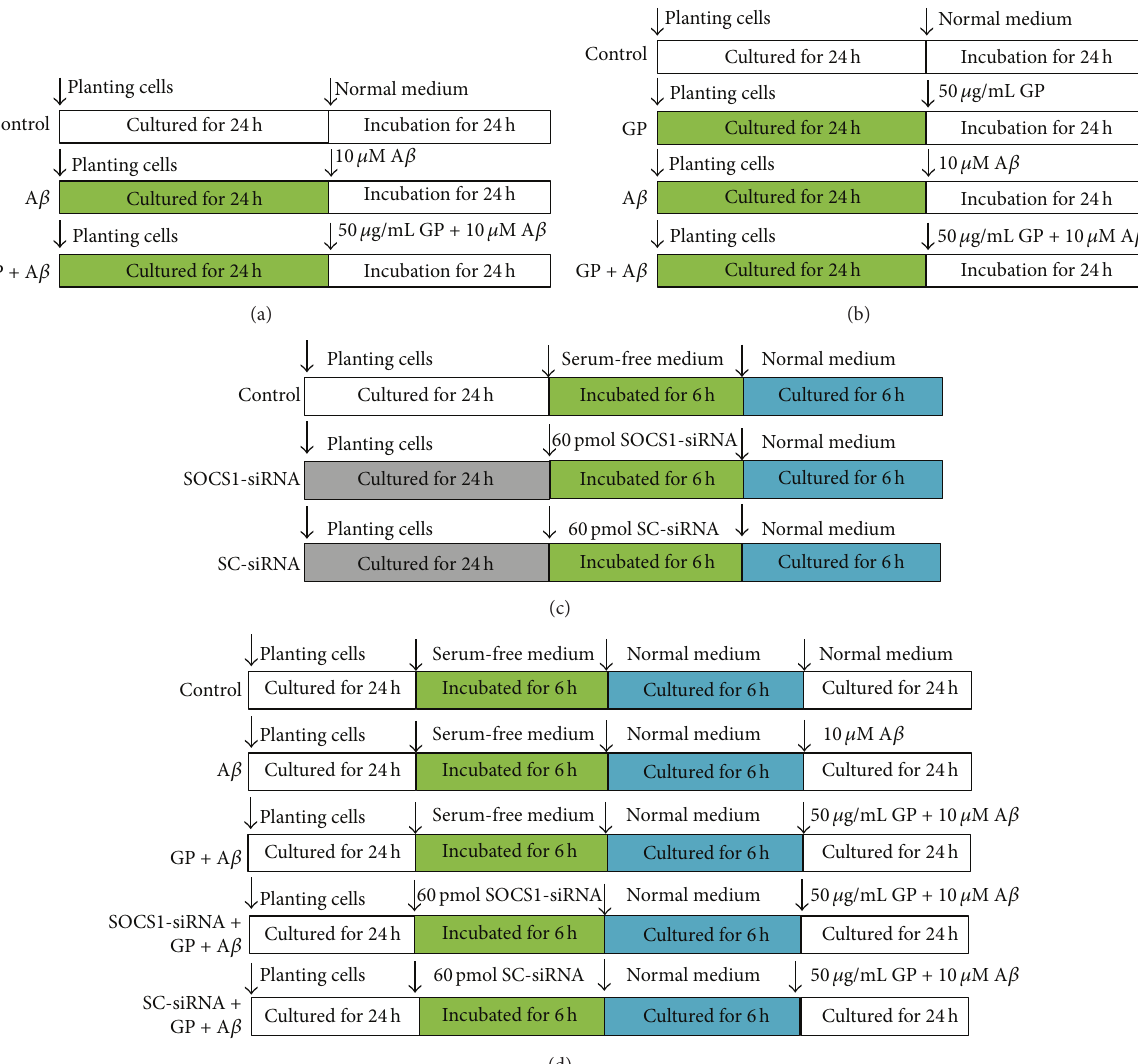
Figure 1: Experimental protocol diagram. (a) The N9 cells were divided into three groups; after being treated for 24h as shown in the figure, western blot analysis and immunocytochemistry were performed to assess iNOS and Arg-1 protein expressions. (b) The cells were divided into four groups, after 24-h incubation, western blot and ELISA were used to evaluate IBA-1 expression and cytokines releases, respectively. (c) The cells were divided into three groups, after being treated as shown in the figure, western blot was used to evaluate the SOCS1-siRNA- induced SOCS1 protein expression. (d) The cells were divided into five groups, after the treatments, iNOS and Arg-1 expressions and cytokines releases were